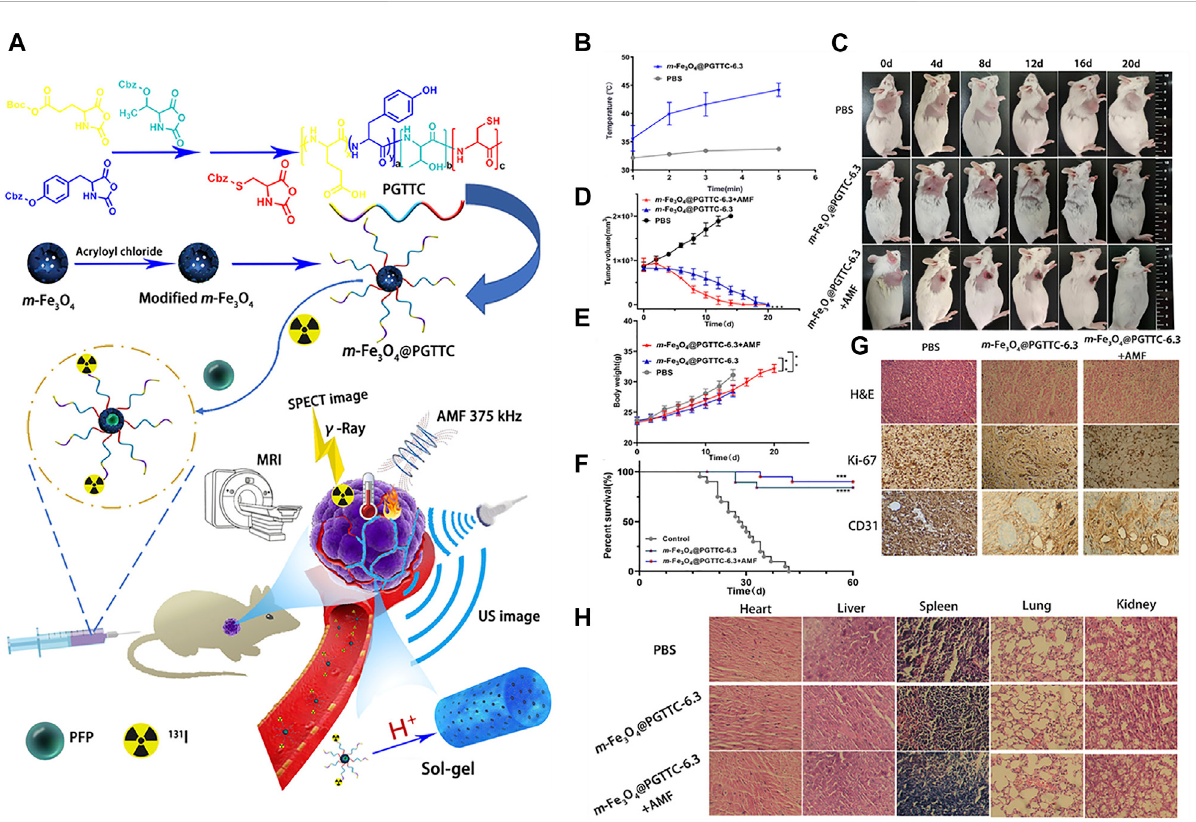
FIGURE 1 (A) Design and application of PFP-m-Fe3O4@PGTTC, (B) temperatures of the tumor tissue at various time points, (C) photographs of H22- tumor-bearing mice with various treatments. (D) Comparison of subcutaneous tumor volume changes among groups, (E) comparison of subcutaneous body weight changes among groups, (F) survival curves of mice within 60 days, (G) representative H&E-, Ki-67-, and CD31-stained images of tumor slices collected from mice in various groups, and (H) H&E-stained images of the major organs (heart, liver, spleen, lung,